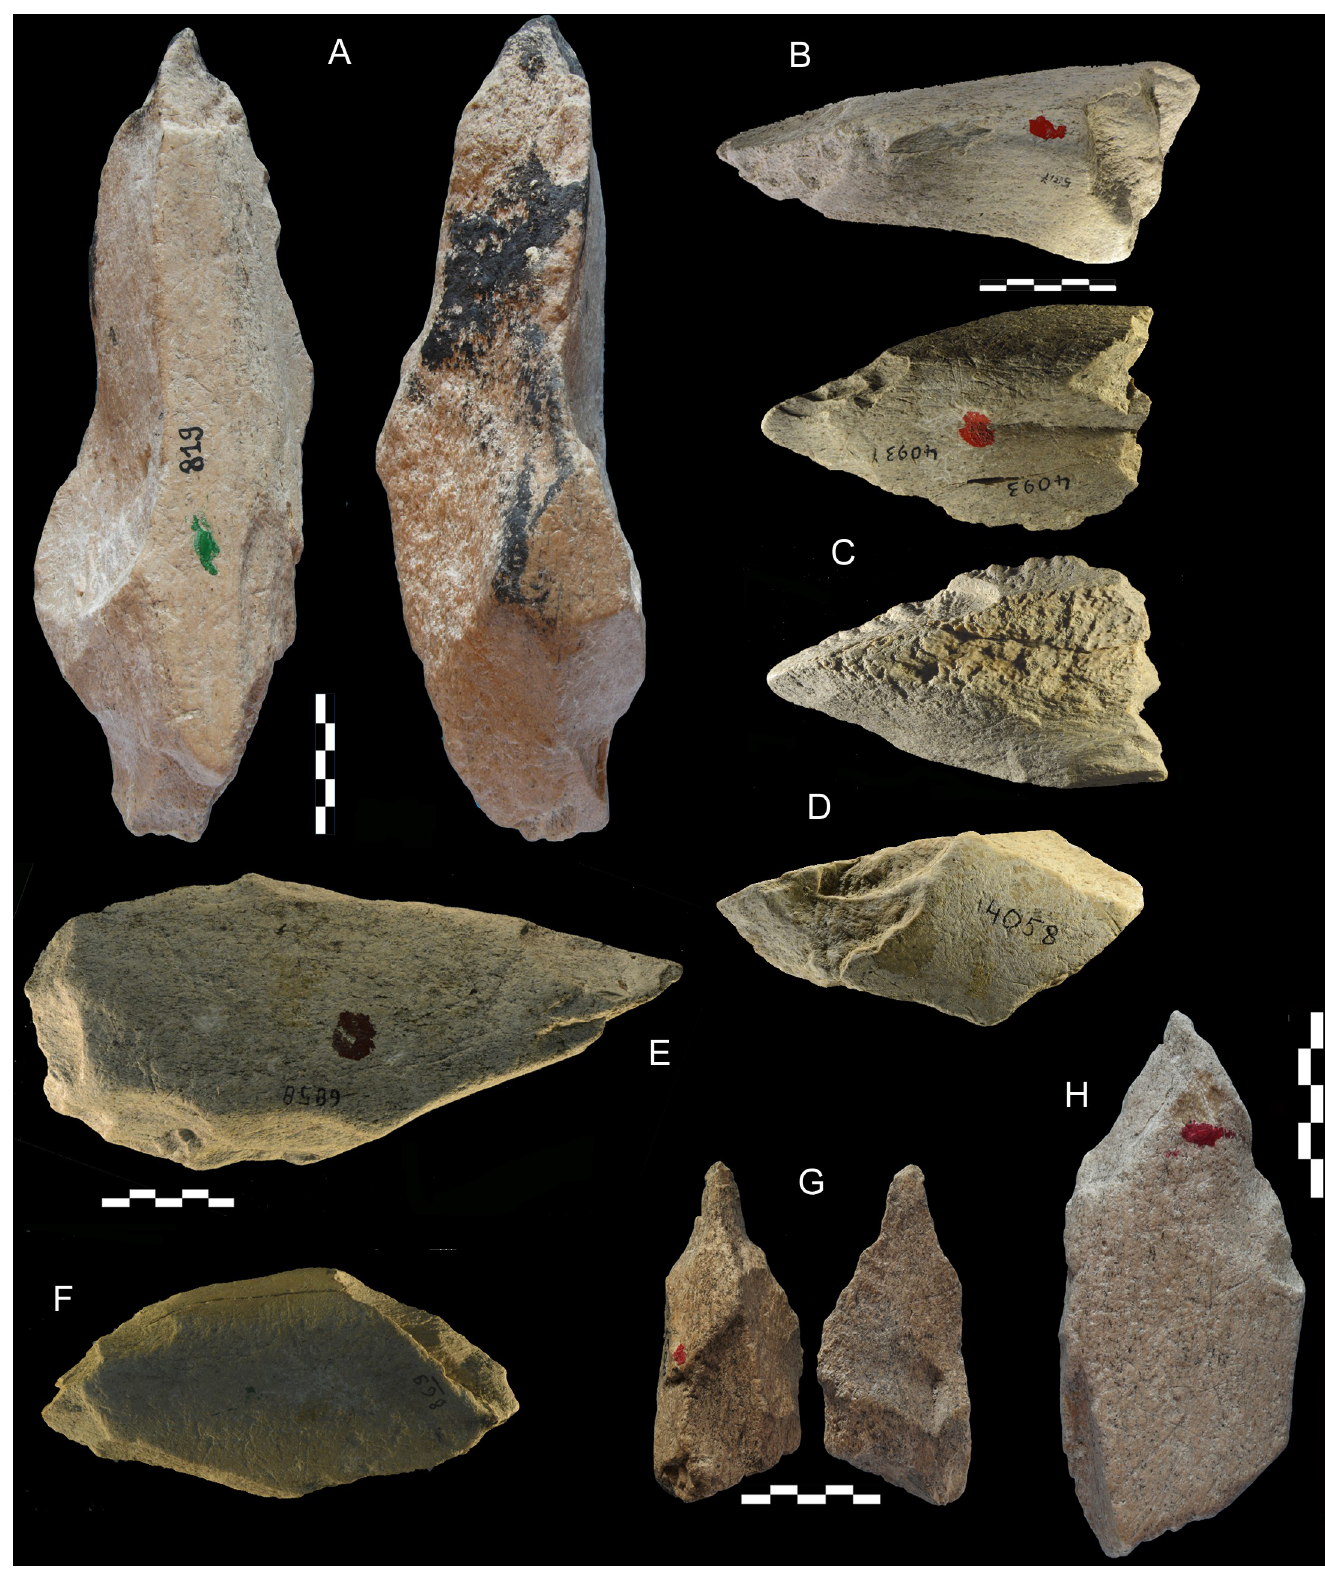
Fig 10. Castel di Guido. Pointed tools, abraded or slightly abraded (A-H). Catalogue numbers 819, 4093, 5817, 4058, 6858, 869, 3508, 2370. B and C can be classed as pointed wedges. https://doi.org/10.1371/journal.pone.0256090.g010 PLOS ONE | https://doi.org/10.1371/journal.pone.0256090 August 26,